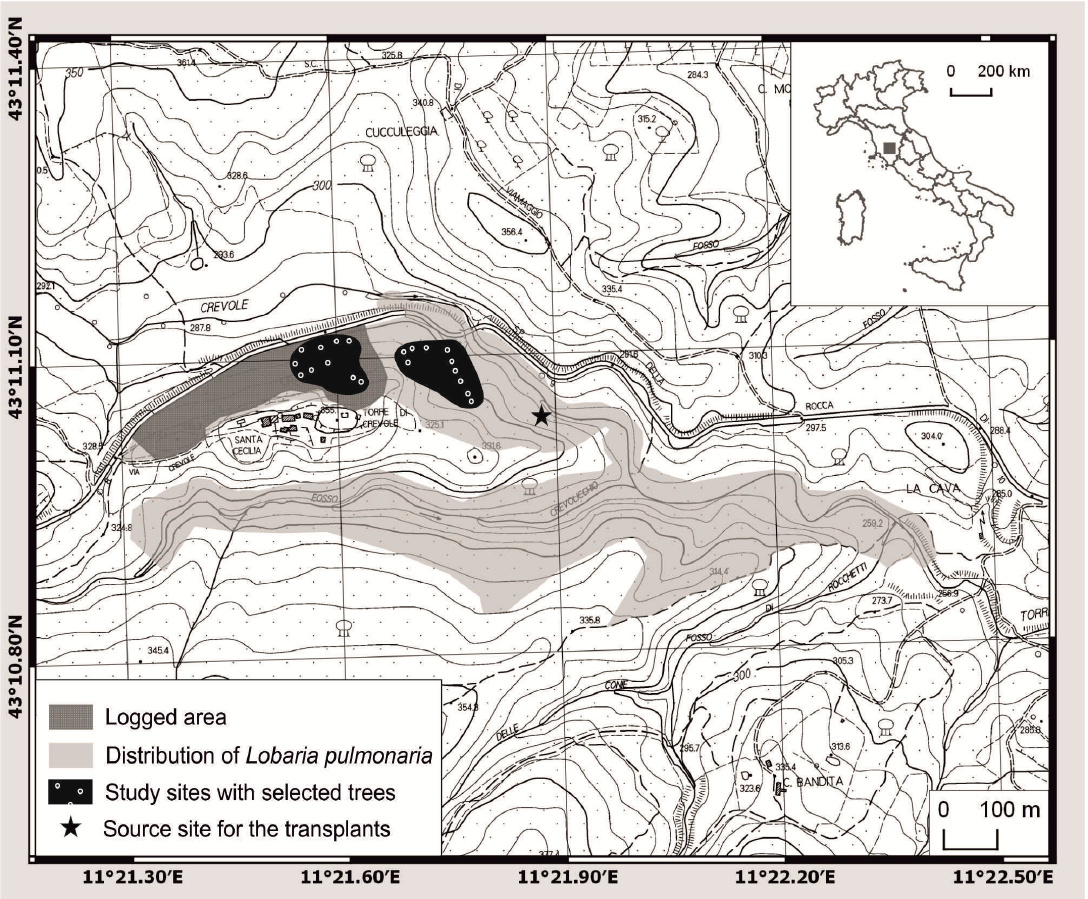
Figure 1. Map of the study sites. Taken from Paoli et al., [48] (modified).